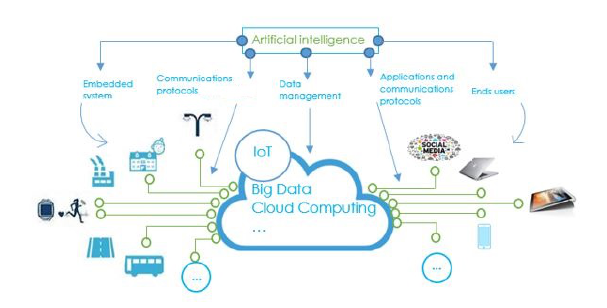
Figure 6. Technical framework for future